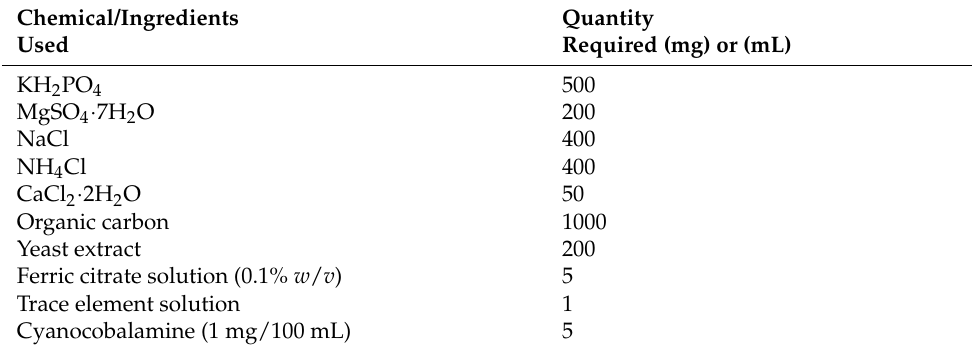
Table 5. Composition of enrichment medium (Biebl and Pfennig’s medium).